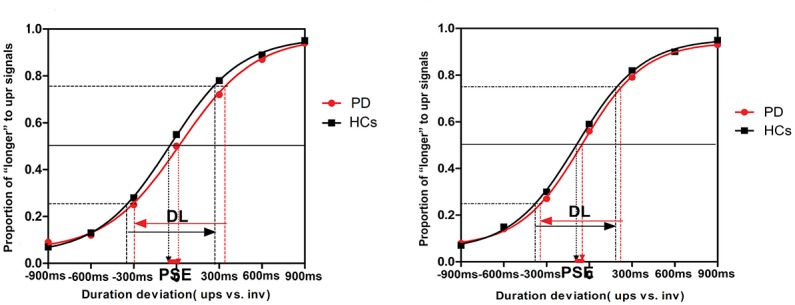
Psychometric functions in two conditions.(A) Psychometric function in the scrambled biological condition: the X-axis shows the deviation in the durations of the two stimuli (upright minus inverted), ranging from -900 ms to +900 ms; the Y-axis shows the proportion of “long” responses to upright stimuli. The arrow with the dashed line indicates the PSE, and the arrows with solid lines indicate the DL. A negative PSE indicates a temporal dilation effect for upright stimuli. (B) Psychometric function in the canonical biological condition. The psychometric functions shown represent the means of these individual functions.